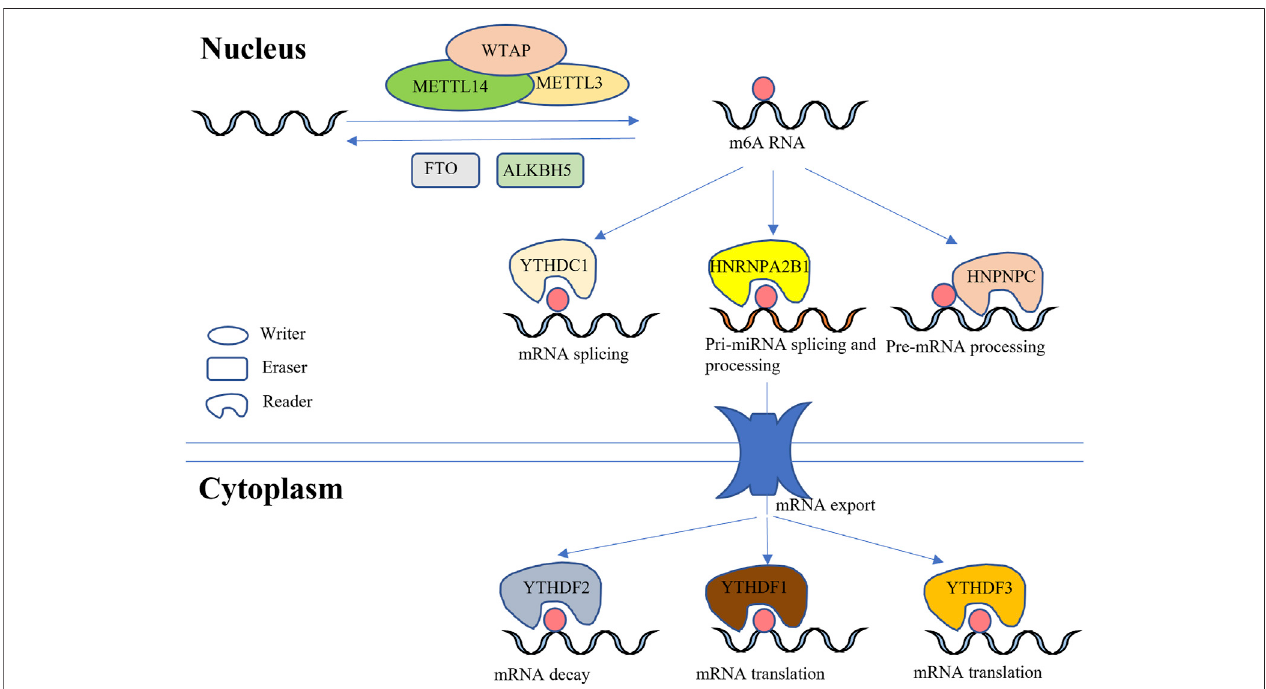
FIGURE 1 | Coordination between writer, eraser and reader. The ellipse represents the writer, which possesses the ability to catalyze RNA into m 6 A-containing RNA. The rectangle indicates the eraser, which moves m 6 A, thereby downregulating m 6 A-RNA. Precise coordination between the writer and eraser allows for dynamic and reversible regulationofm 6 Alevels ineukaryocytes.Theirregular shaperepresentsthereader,whichbindsm 6 Aand modulatesexpression ofimportantgenes.Both the nucleus and cytoplasm contain reader, and different readers play unique roles in the physiological functioning of organisms. Some readers, notably YTHDF1 and YTHDF3, promote the expression of speci fi c genes, whereas YTHDF2 has the opposite effect, decreasing mRNA levels.